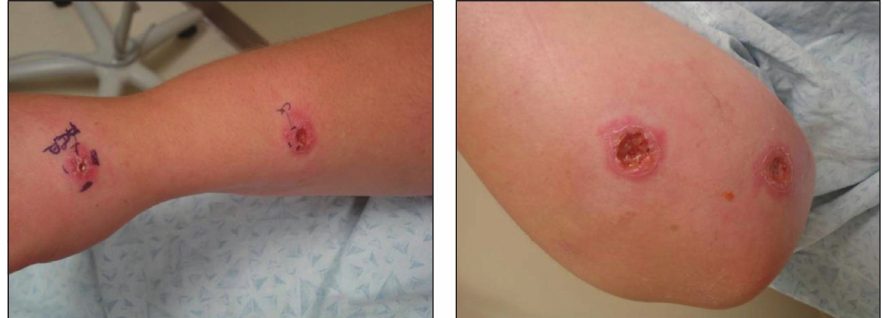
Figure 1: Patient with ulcerated, erythematous papules in sporotrichoid distribution on right upper arm.